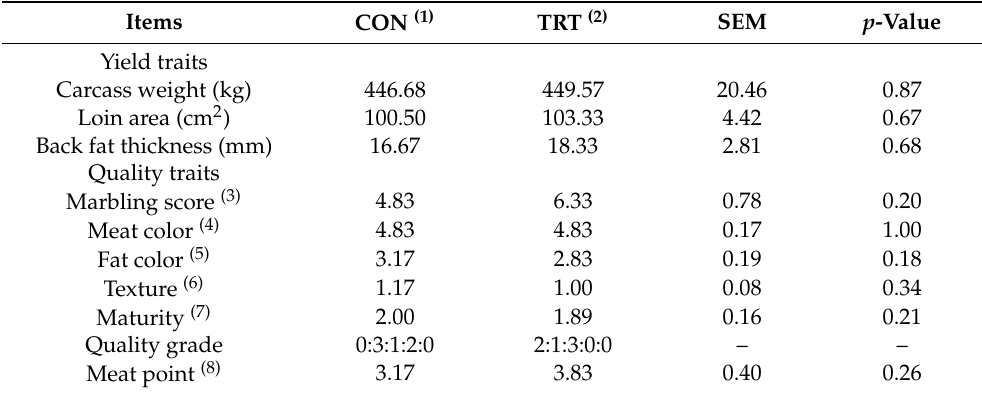
Table 4. Effect of stevioside and organic selenium supplementation on carcass traits of Hanwoo cattle.